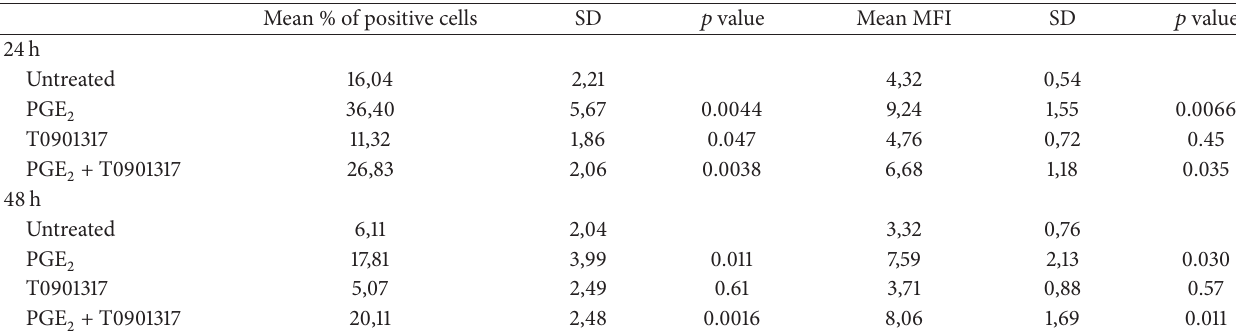
Table 2: Statistical analyses of CCR7 surface expression in MM-1 cells.